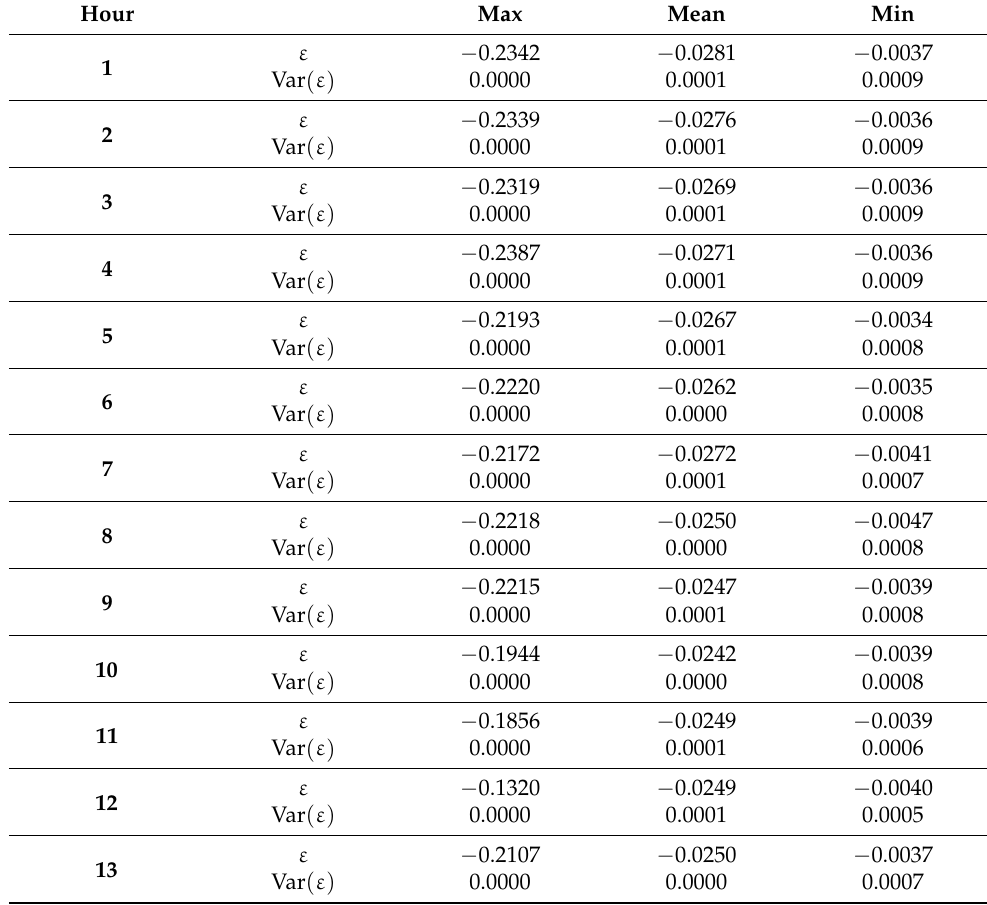
Table 6. Summary Statistics of the Hourly Elasticity